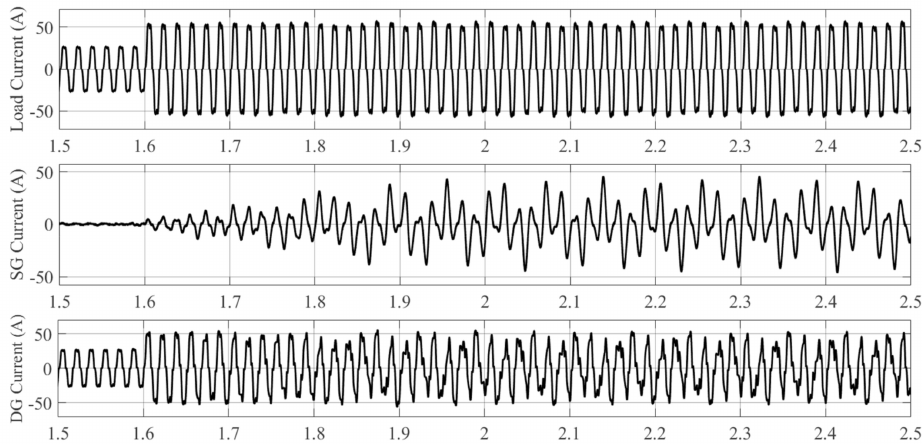
Figure 17. Load, SG, and DG currents before and after connecting the additional nonlinear